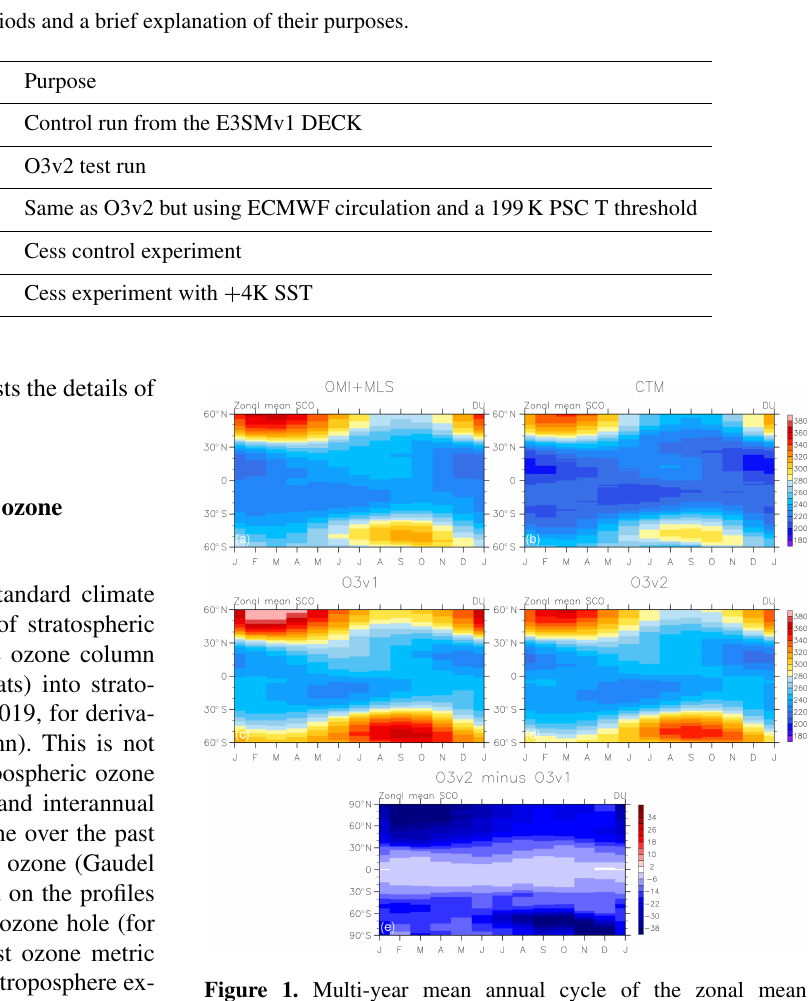
Figure 1. Multi-year mean annual cycle of the zonal mean stratosphere-only column ozone (SCO, in Dobson units). The SCO from (a) OMI + MLS observations are for the years 2005–2017; that from (b) UCI CTM are for the years 2005–2017; and those from E3SM (c) O3v1 and (d) O3v2 are for the years 1995–2014 as forced by observed SSTs. Comparison with observed SCO is limited to 60 ◦ S–60 ◦ N by the better observational data. (e) The difference in SCO of O3v2 minus O3v1 for 90 ◦ S–90 ◦